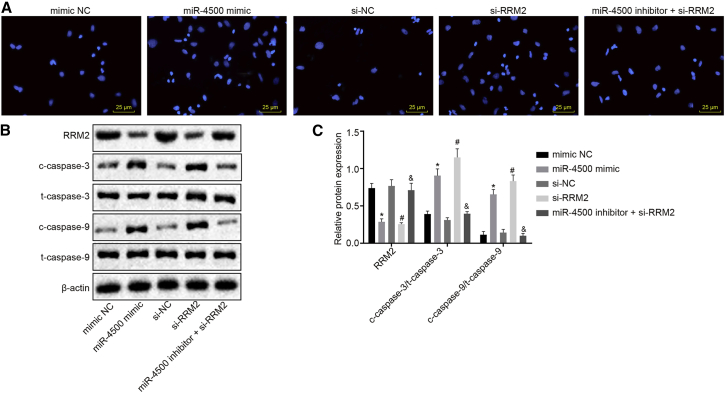
Overexpression of miR-4500 Inhibits the Expression of RRM2 to Promote Breast Cancer Cell Apoptosis(A) The cell apoptosis detected by Hoechst staining (400×). (B) The protein bands of cell apoptosis-related factors c-caspase-3/t-caspase-3 and c-caspase-9/t-caspase-9 detected by western blot analysis. (C) The protein-expression patterns of cell apoptosis-related factors c-caspase-3/t-caspase-3 and c-caspase-9/t-caspase-9 in each group detected by western blot analysis. *, #, and &p < 0.05 versus the mimic NC group, si-NC group, and si-RRM2 group, respectively. The data comparisons were analyzed by one-way ANOVA, and the experiment was repeated three times independently.